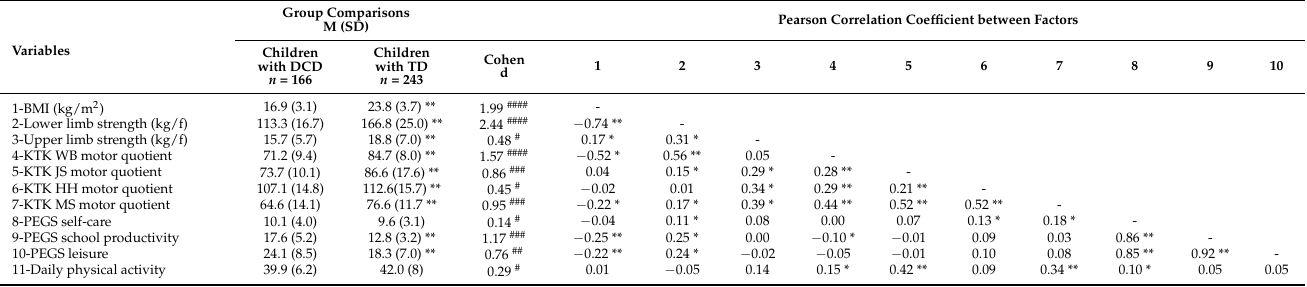
Table 1. Descriptive statistics, comparison analysis between DCD group ( n = 166) and TD group ( n = 243), and correlations for the total sample ( n =